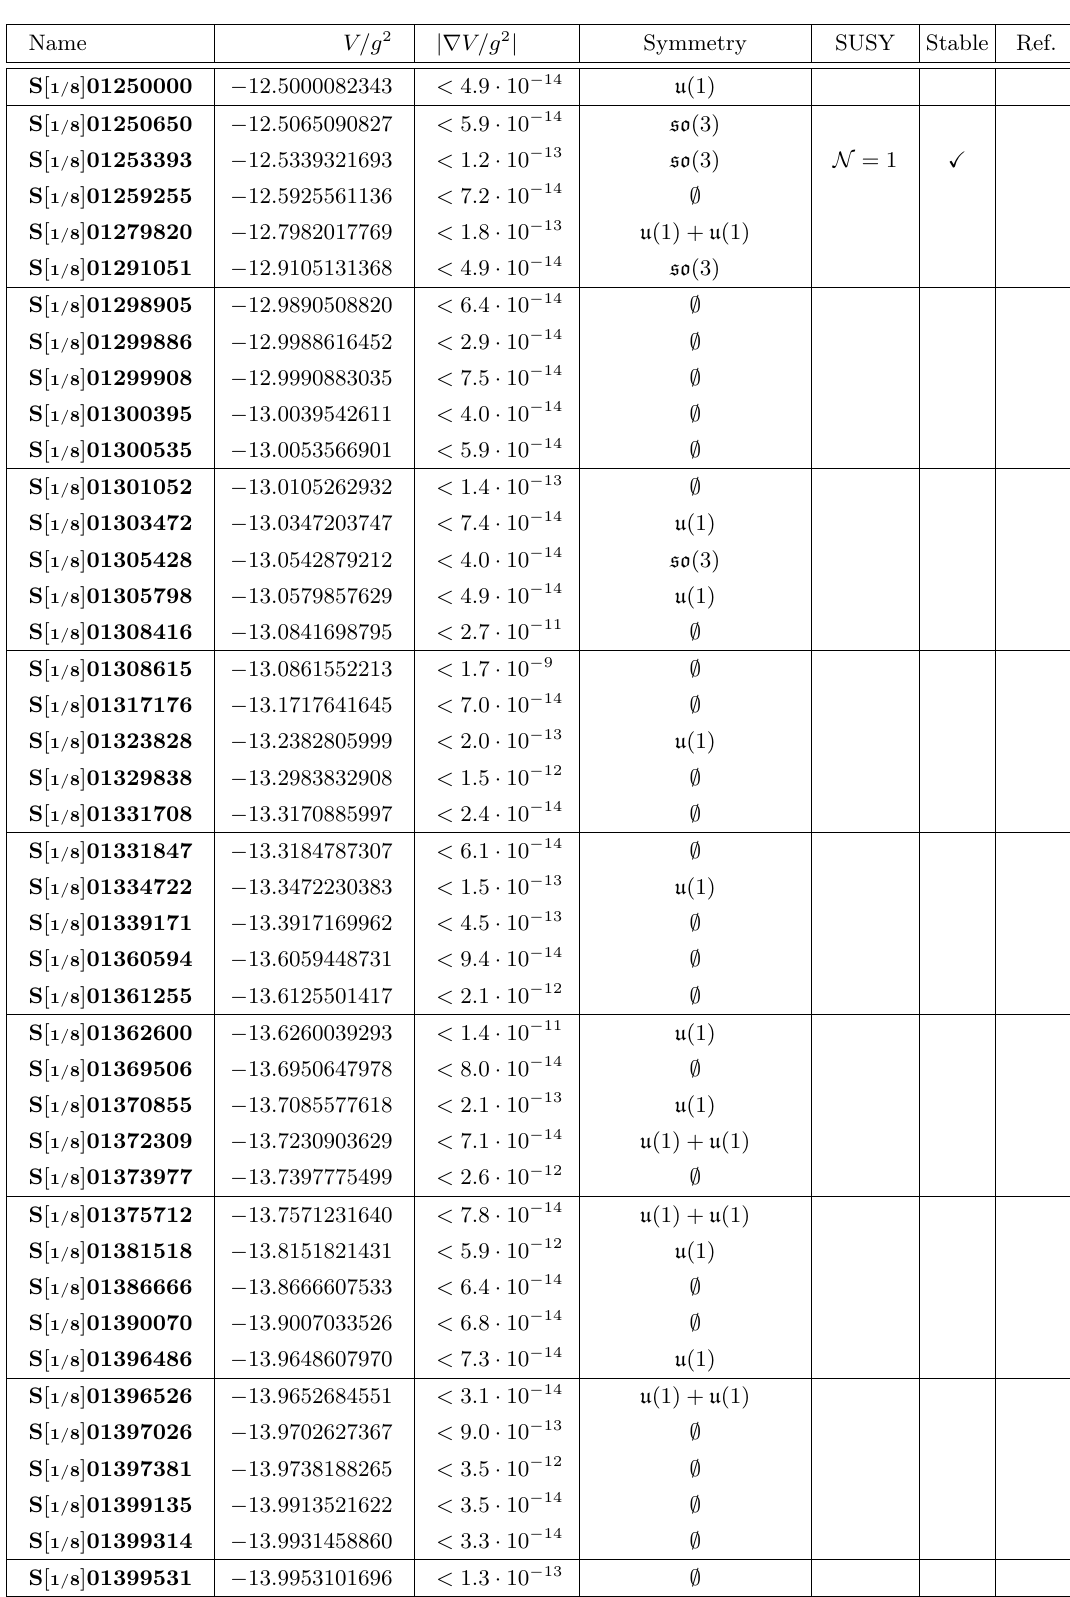
Table 1. Summary of vacua at ω = π/ 8